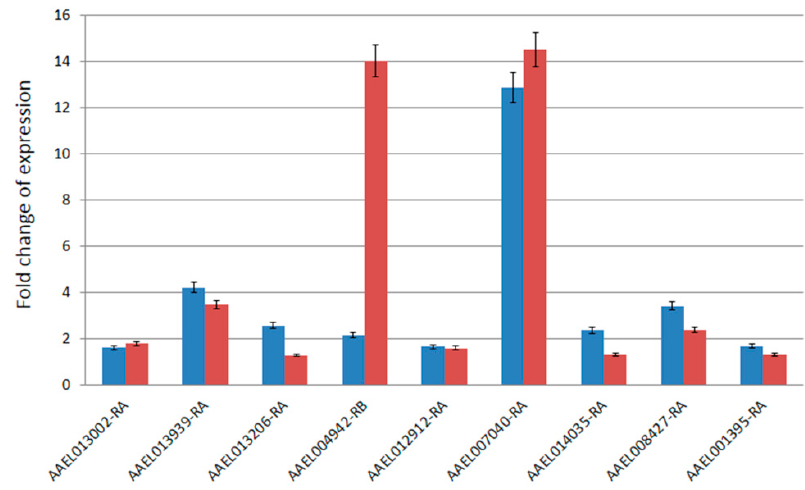
Figure 2. Comparison of fold-changes of expression of nine genes between microarray data (blue) and RT-qPCR data (red). The x-axis shows the VectorBase ID of the nine genes and y-axis shows the fold changes of expression. The error bars shown represent standard error of data.